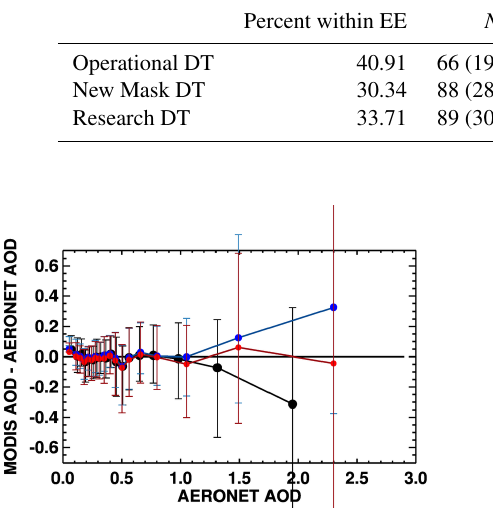
Figure 11. Time series of daily averaged AERONET observations of AOD at 0.55µm (in gray) as a function of Julian day in 2013 and the corresponding daily operational MODIS DT (in blue) and research (in red) AOD over the Xianghe AERONET